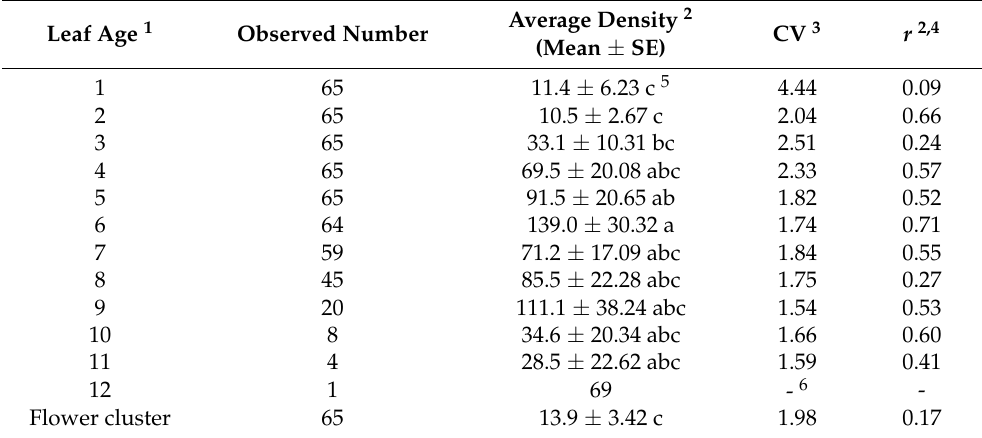
Table 1. Observed plant number, average density, coefficient of variation (CV), and coefficient of determination ( r 2 ) of T. urticae eggs according to leaf age within a strawberry plant. Leaf Age 1